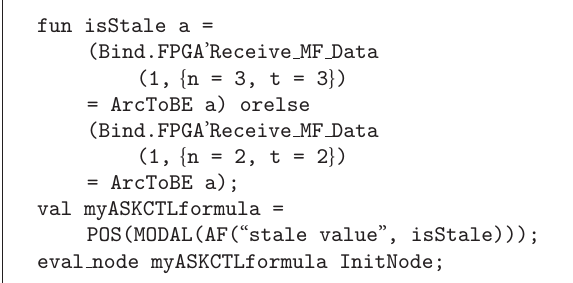
Table 3: Property related functions.